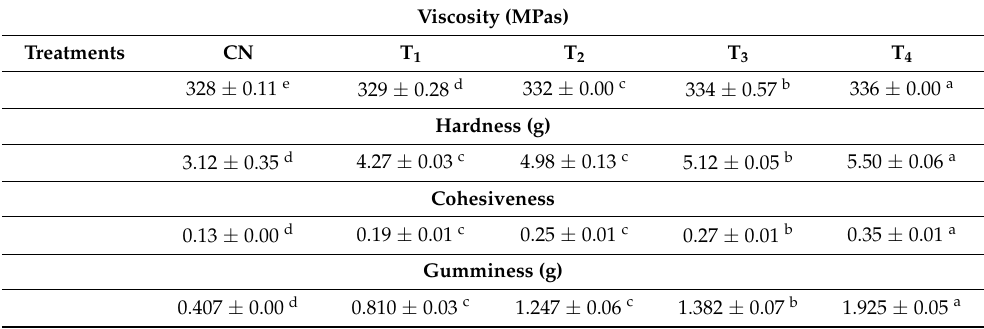
Table 3. Changes in texture profile and viscosity in fresh frozen yoghurt mixes affected by adding substantial ratios of JATP during cold storage.